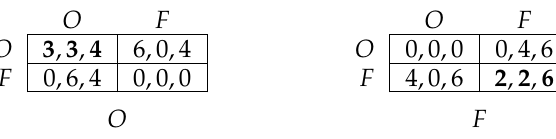
Figure 1. Battle of the sexes with 2–1 sex